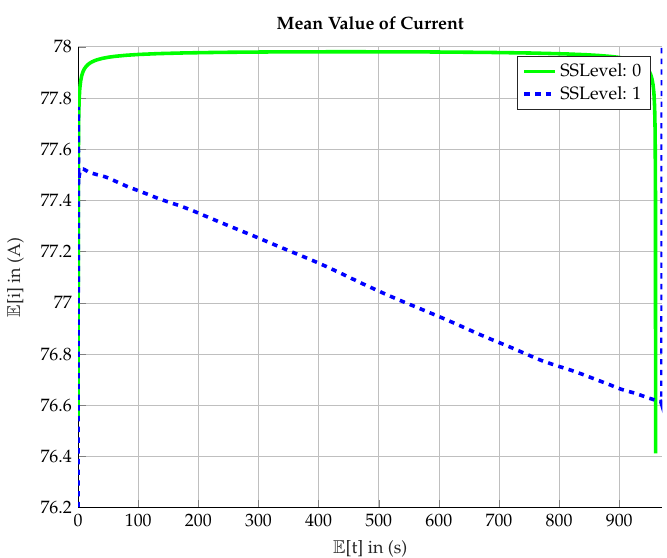
Figure 6. Robust control history for the current as the command variable over time for charging.